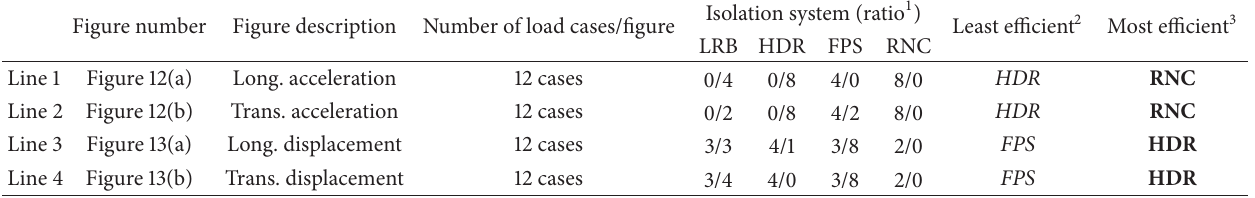
Table 4: Relative efficiency measure of the four isolation systems based on their influence on the deck’s peak acceleration and displacement. Figure number Figure description Number of load cases/figure